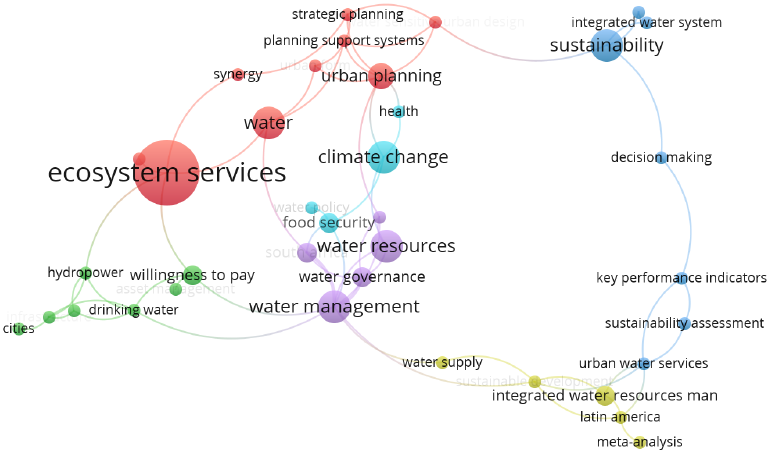
Figure 9. Keyword network of the selected sample. Data from Scopus, visualizing by VOSviwer 1.6.18.